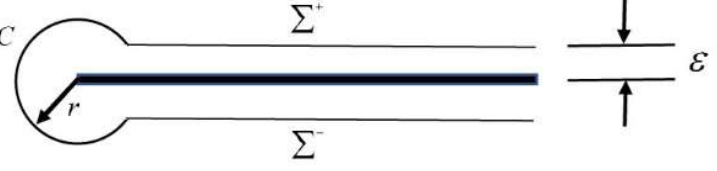
Figure 3. Contour surrounding piezoelectric quasicrystal dislocation core and slip plane.